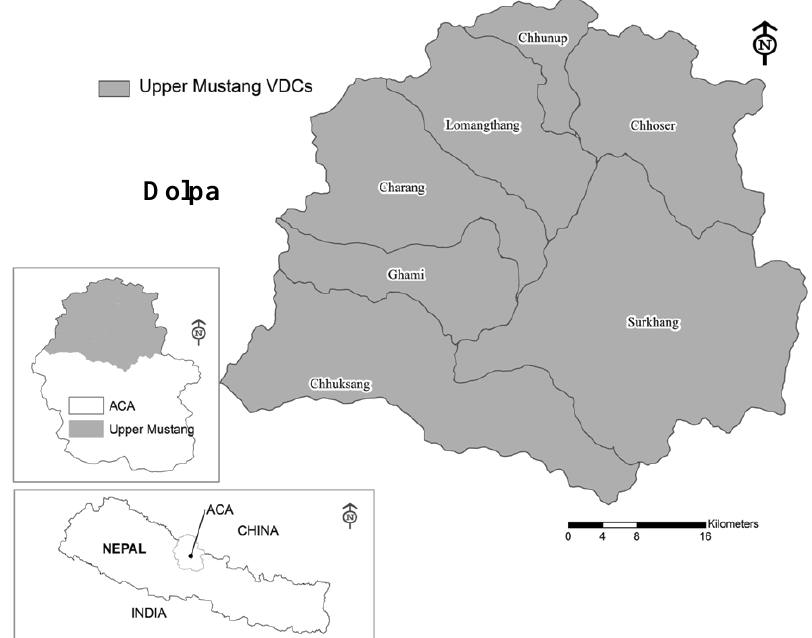
Figure 1. Location of the study area within Nepal.